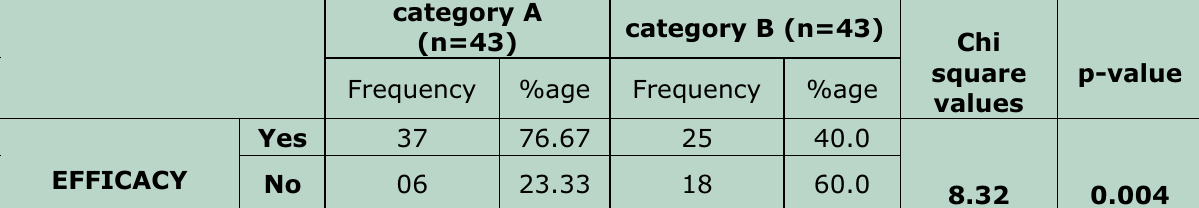
Table-III: Comparison of Efficiency (in terms of stone removal) between both categories